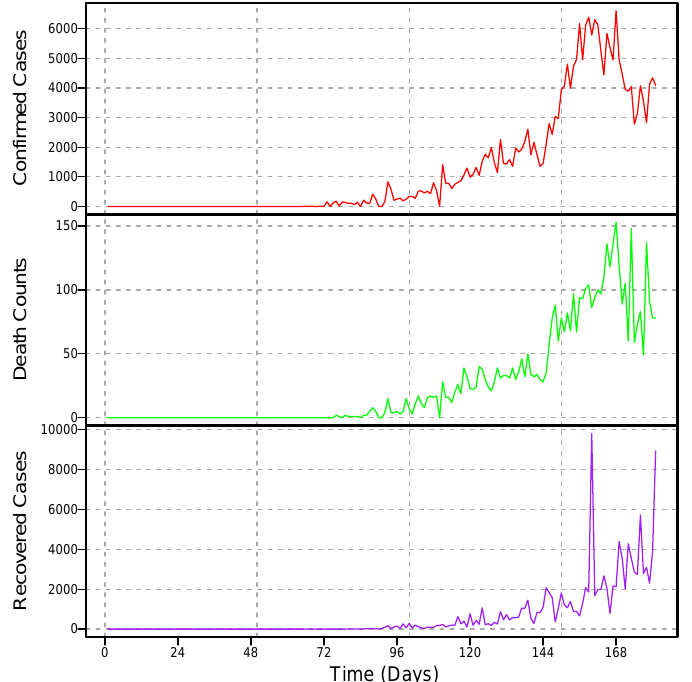
Figure 1. Pakistan COVID-19: daily confirmed cases (1st panel), death counts (2nd panel), and recovered cases (3rd panel) over the period of 28 February to 3 July 2020.